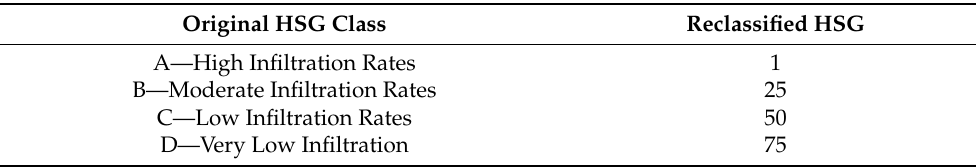
Table 3. Original HSG categories and their reclassification through ArcGIS to a numerical value for forthcoming data processing and